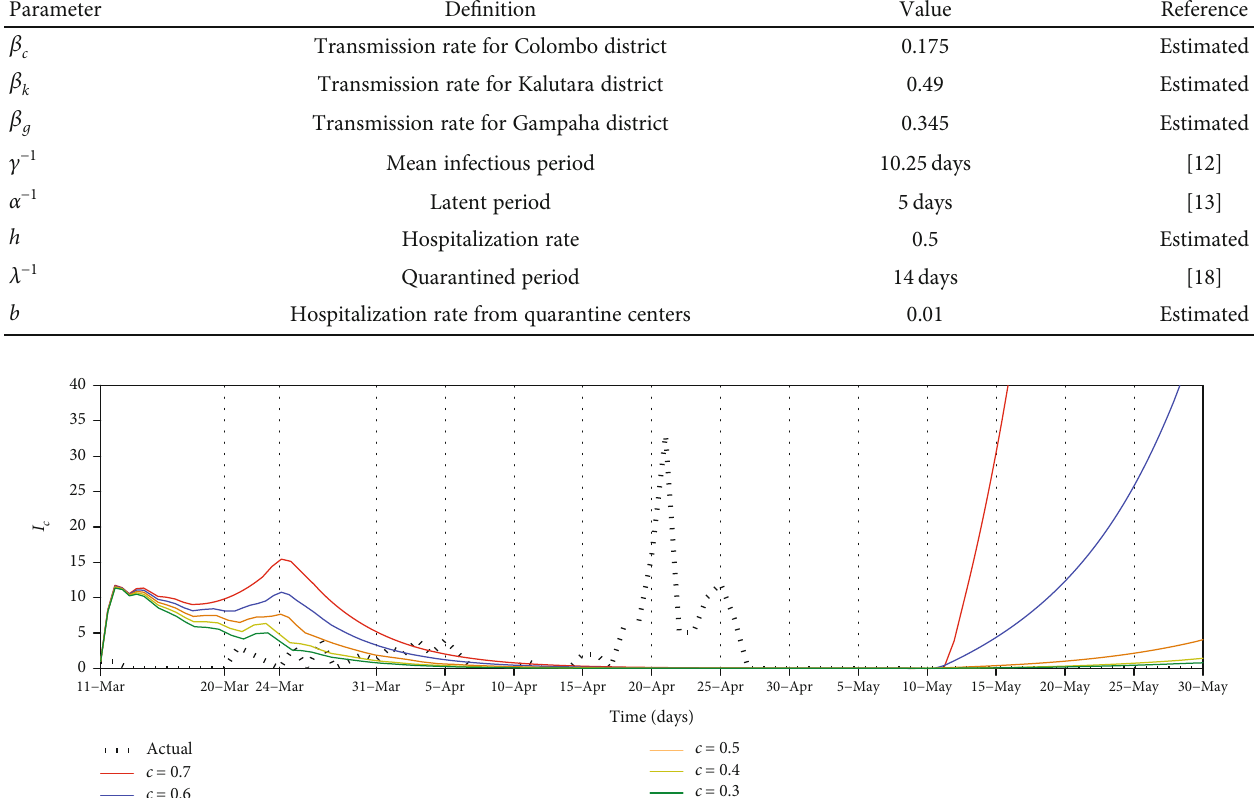
Figure 3: Comparison of actual infected data and simulation results for di ff erent contact rate values in Colombo